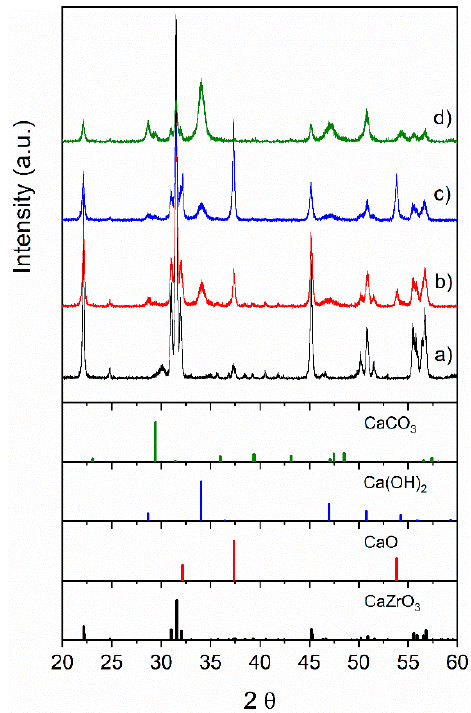
Figure 1. X–ray di ff raction (XRD) patterns of as–prepared samples: (a) CZ, (b) CCZ40, (c) CCZ60, and (d) CCZ80. The position and intensity of the peaks corresponding to the main phases present are also included.